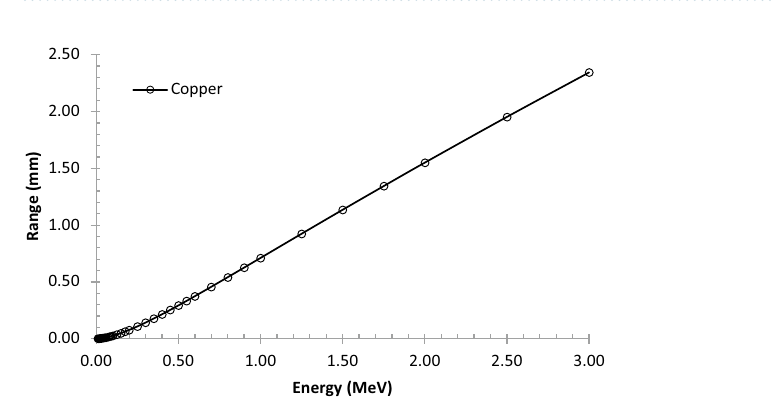
Figure 4. Calculation of electrons range versus Bi 2 O 3 wt% for electrons at energies of ( a ) 546.2 keV and ( b ) 2.28 MeV using the ESTAR program in the PC–Bi 2 O 3 composite.